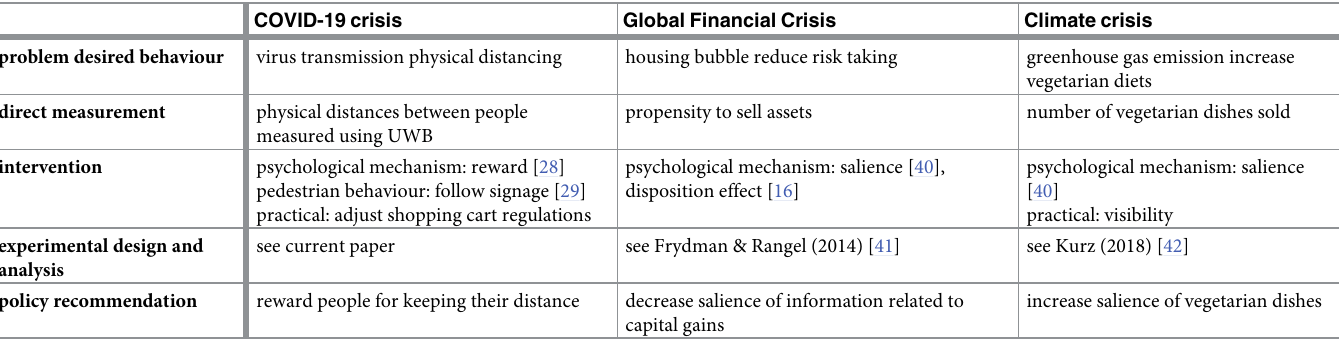
Table 3. Examples on how behavioural science can be used to develop effective interventions to stimulate desired